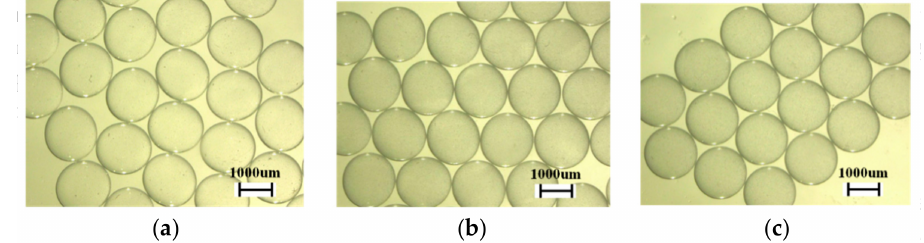
Figure 10. Hollow microspheres cured by di ff erent curing modes. ( a ) Mode 1; ( b ) Mode 2; ( c ) Mode 3.